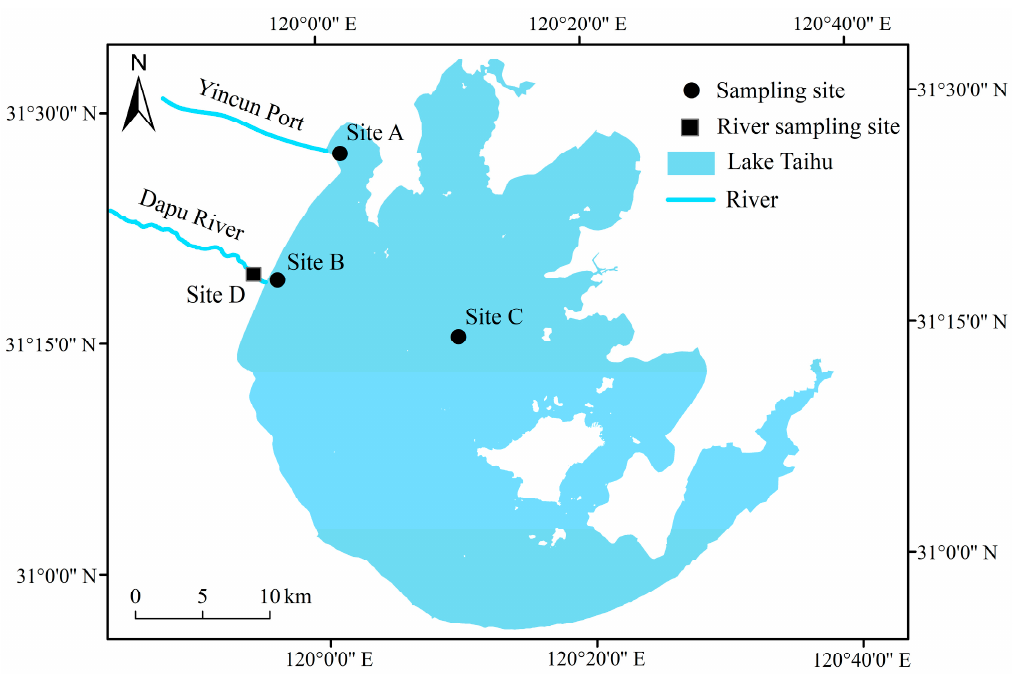
Figure 1. Map showing the three sampling sites in lake (Site A, Site B, and Site C) and the inflowing river (Dapu River) connecting Site B.